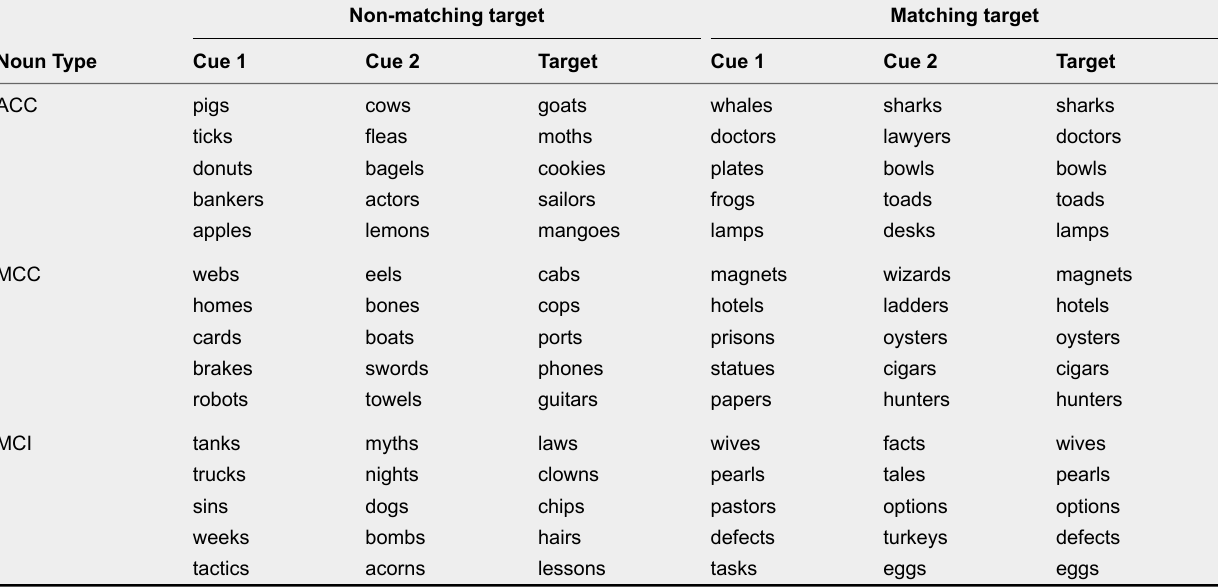
Noun Triplet Examples From the Number Matching Task